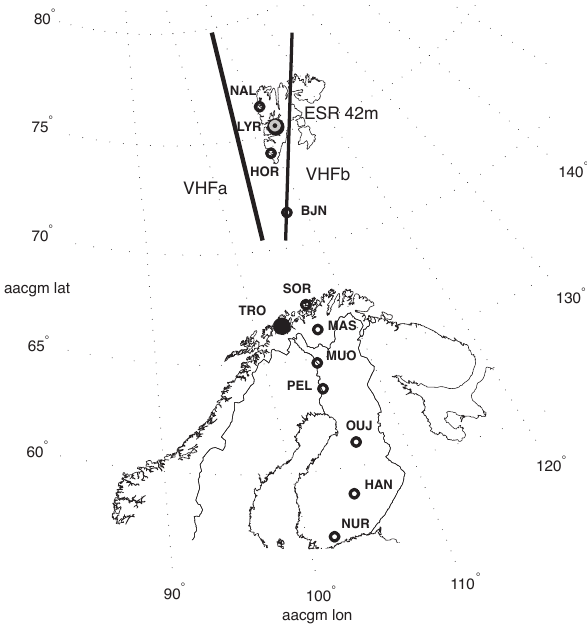
Fig. 1. Black: EISCAT radar locations and radar beam geome- try used on 25 November 2000. The VHF radar is located near Tromsø (TRO) and the field-aligned ESR 42m antenna of the ESR system close to Longyearbyen (LYR) on Svalbard. Black lines are the ground level projections of the two VHF radar beams. Open cir- cles: Stations of the MIRACLE north-south magnetometer